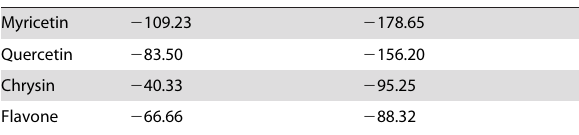
potential energy for the complex of COX bound with the ligand, E COX was the potential energy of the enzyme alone, and E ligand was the potential energy for the ligand alone.